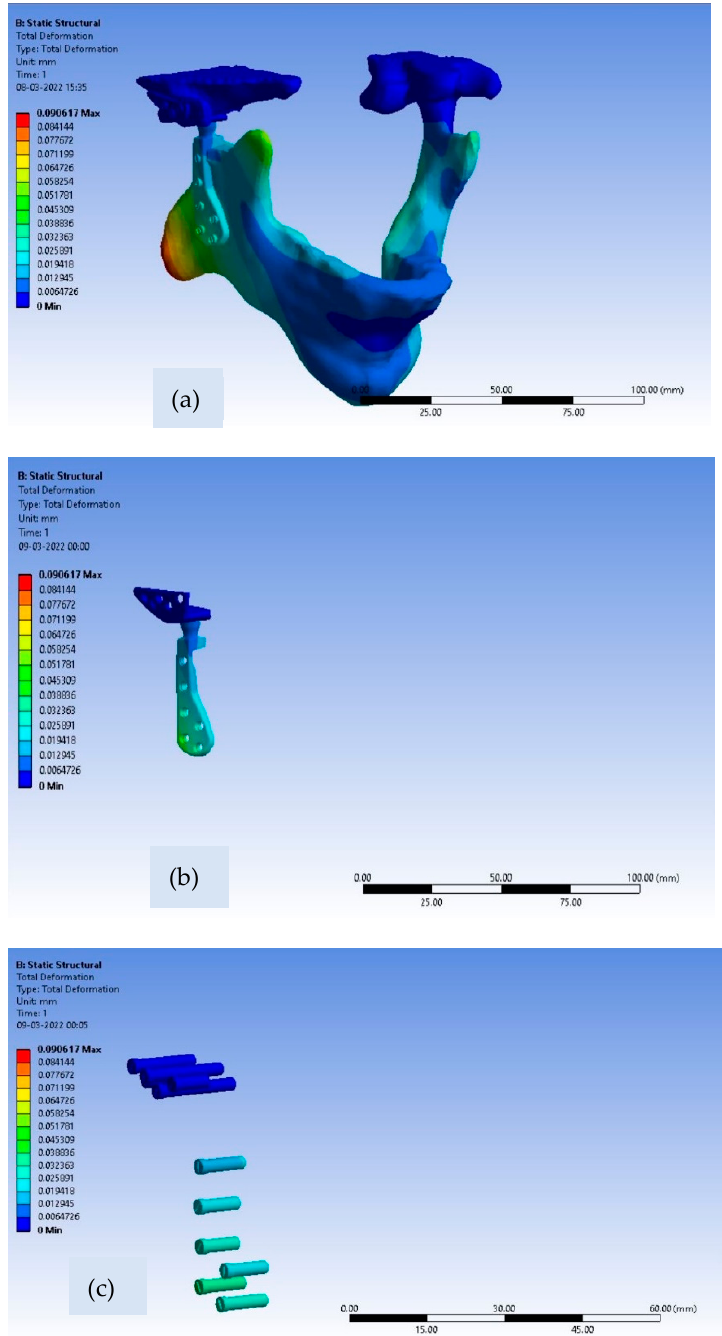
Figure 8. Deformation contours for ( a ) Total TMJ prostheses with mandible ( b ) Condylar and fossa parts without screws ( c ) fossa and condylar screws in case of Ti alloy model of customized TMJ prostheses.